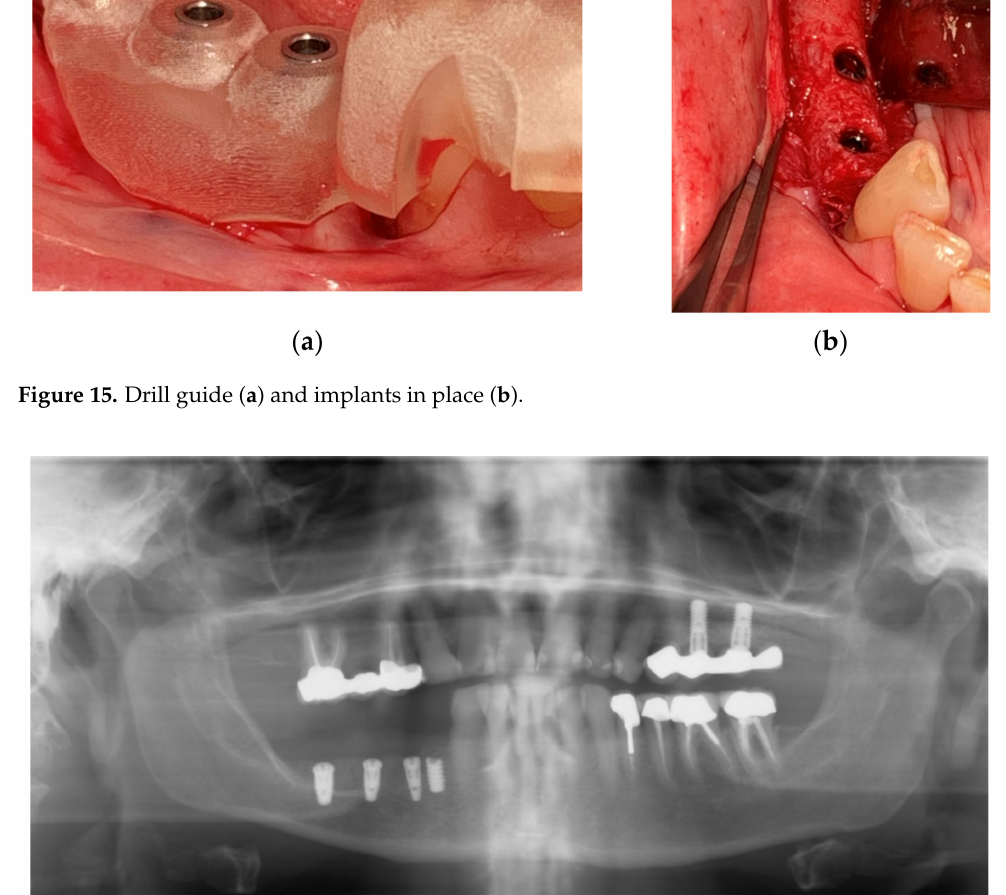
Figure 16. Panoramic radiograph showing the implants in